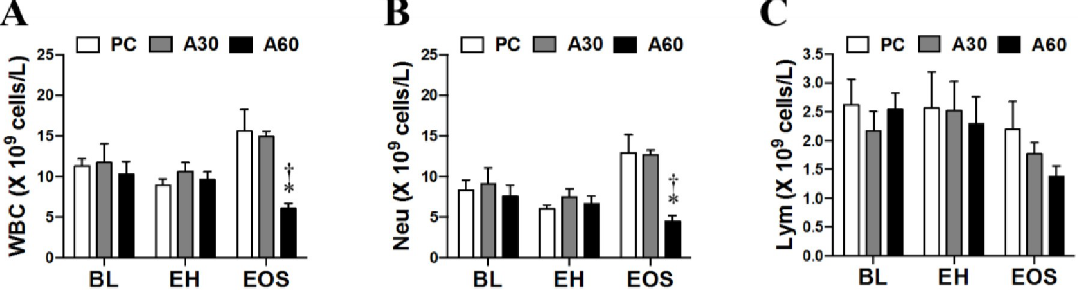
Fig 3. White blood cell counts in swine undergoing cREBOA. Data are presented as mean ± SEM and were statistically analyzed using two-tailed Mann-Whitney test. � p < 0.05, PC vs . A60 group; † p < 0.05, A60 vs . A30 group. WBC, white blood cells; Neu, neutrophils; Lym,